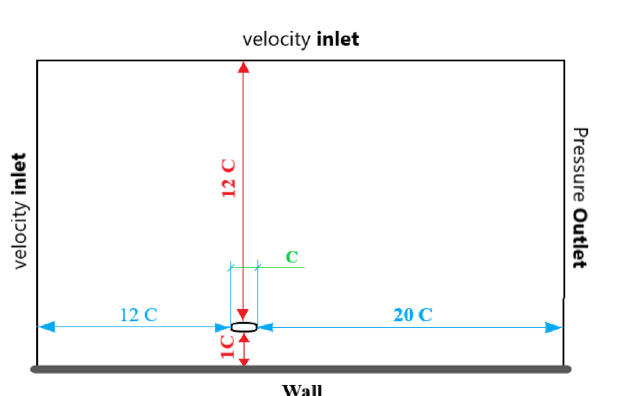
Figure 1. ( a ) Three cross-sections of a dragonfly forewing (Aeshna Cyanea) 37,38 ( b ) Final cross section profile based on profile 2 39 .